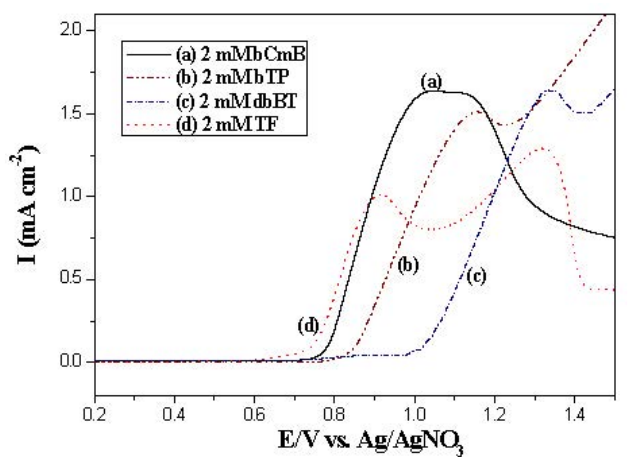
Figure 2. Cyclic voltammograms of ( a ) 2 mM bCmB, ( b ) 2 mM bTP, ( c ) 2 mM dbBT, and ( d ) 2 mM TF containing 0.2 M LiClO 4 at a scan rate of 100 mV s − 1 .